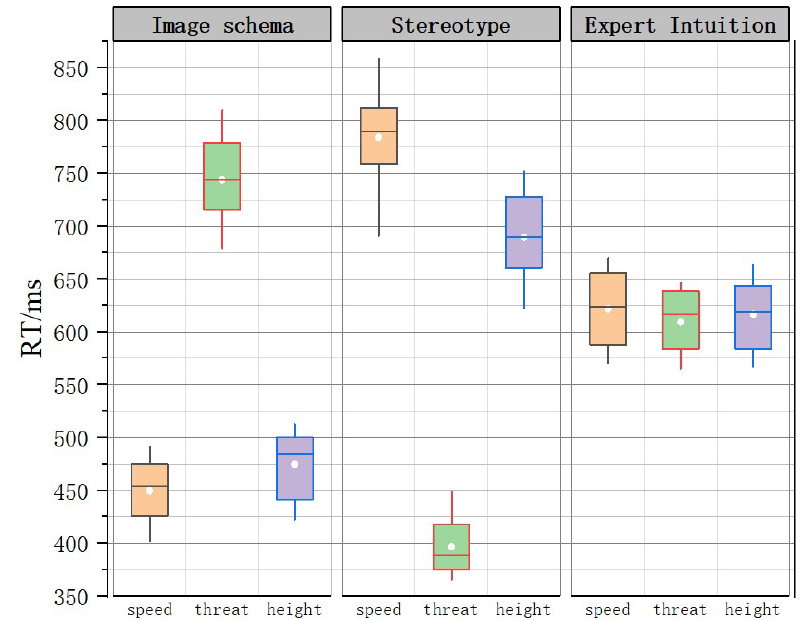
Figure 4. Reaction time data box line